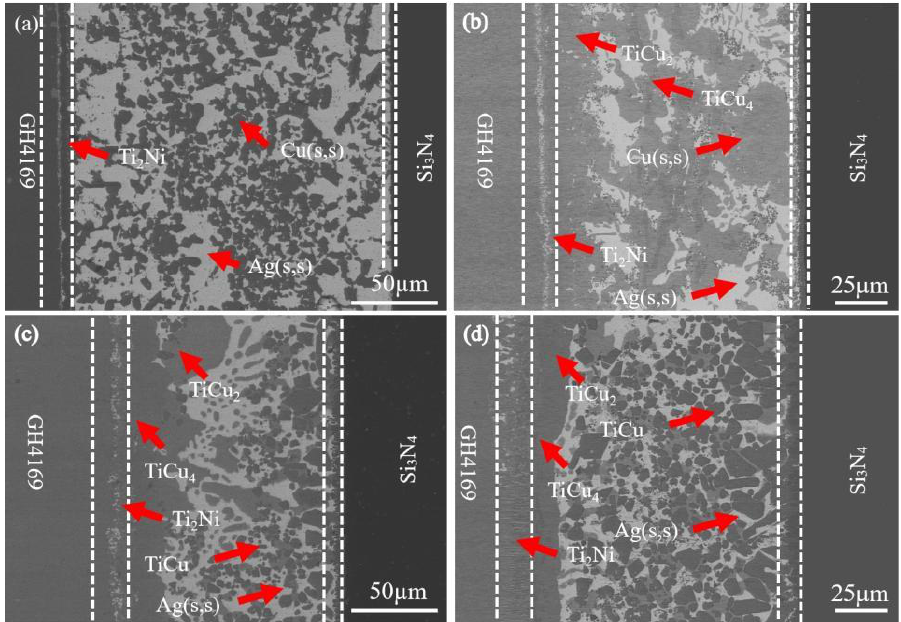
Figure 9. Microstructure of the GH4169/Si 3 N 4 joints brazed at different temperatures for 15 min: ( a ) 820 °C; ( b ) 850 °C; ( c ) 880 °C; ( d ) 910. ( a ) 820 ◦ C; ( b ) 850 ◦ C; ( c ) 880 ◦ C; ( d )